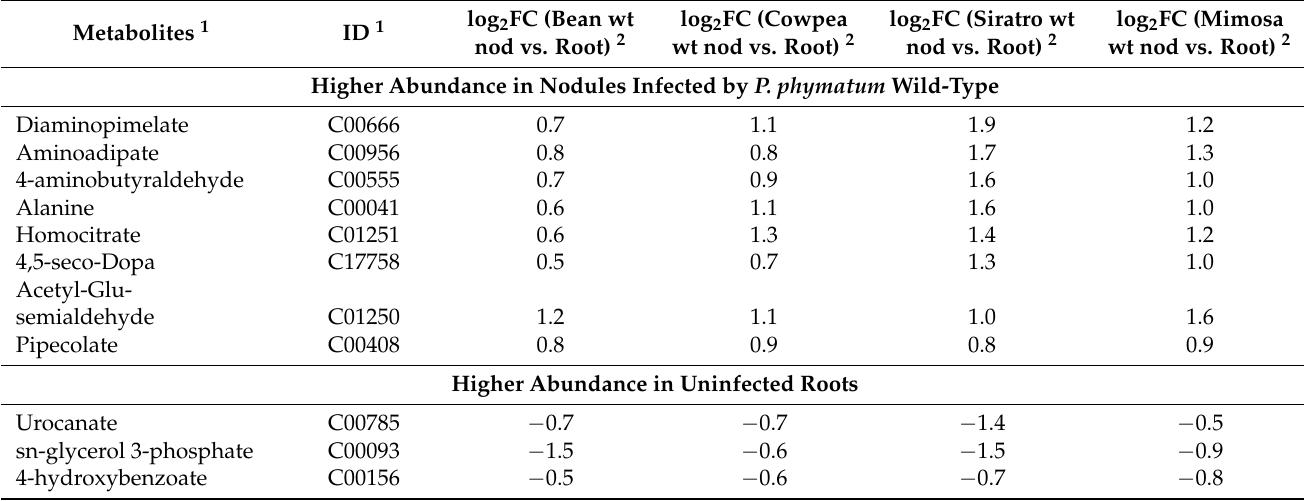
Table 1. List of 11 metabolites that significantly accumulated in P. vulgaris (bean), V. unguiculata (cowpea), M. atropurpureum (siratro) and M. pudica nodules induced by P. phymatum STM815 wild-type (wt nod) compared to the non-root samples (root). Metabolites 1 Higher Abundance in Nodules Infected by P. phymatum